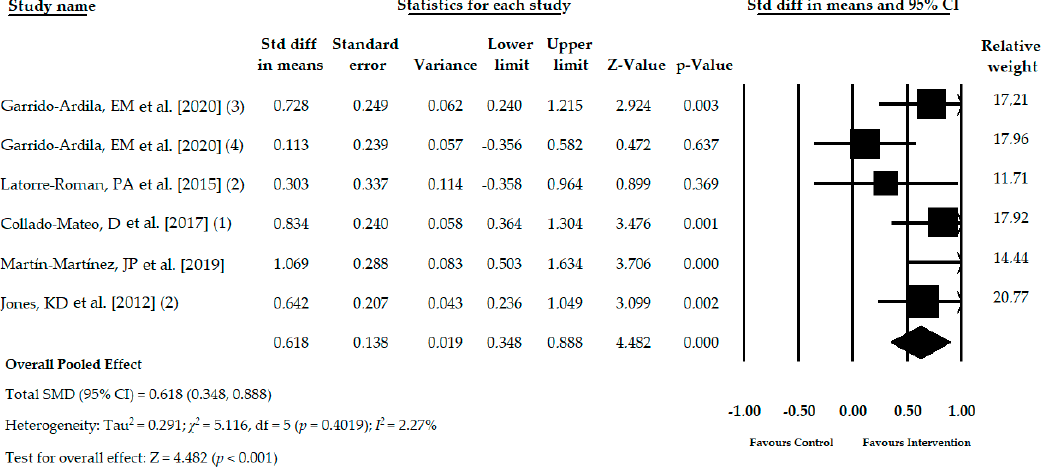
Figure 3. Forest plot of the meta-analysis of the immediate e ff ect of the ATBT in dynamic balance .